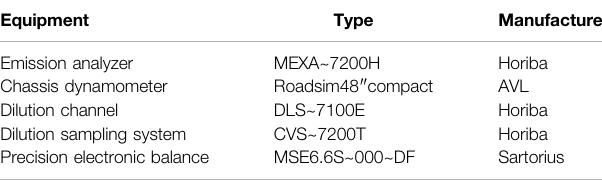
TABLE 2 | Manufacturers and types of instruments (Liu, et al., 2019). Equipment